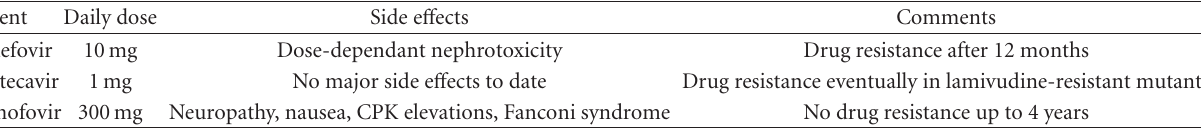
Table 3: Antiviral Agents with Activity against Wild Type and Lamivudine resistant